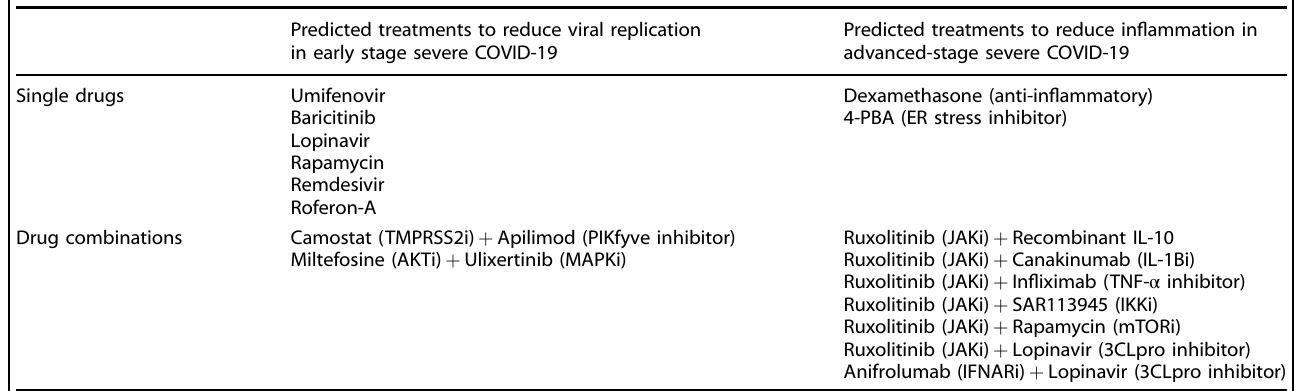
Drug treatments predicted by the computational model to be effective in early or late stage severe